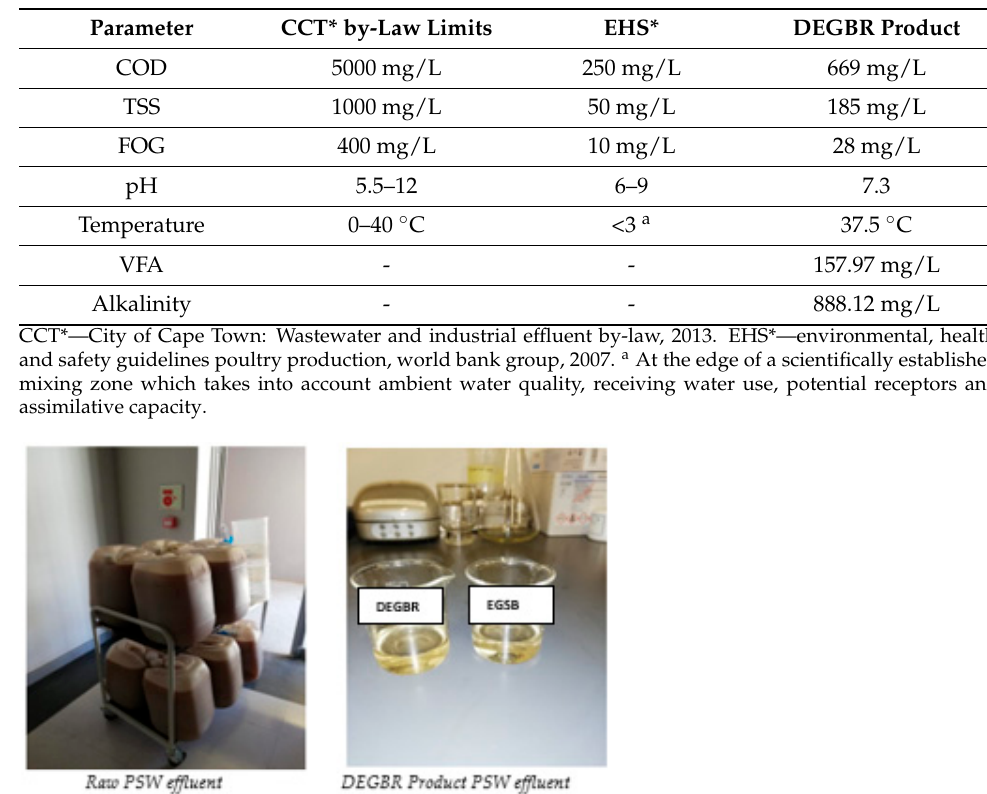
Table 4. DEGBR’s product in comparison to City of Cape Town’s specifications and others.